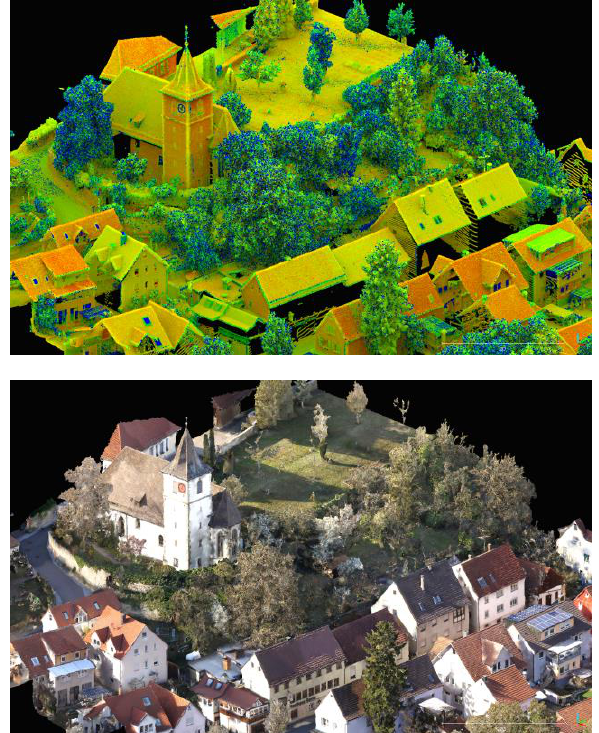
Figure 9. LiDAR point cloud with corresponding colour coded reflectance (top) and 3D mesh with corresponding image texture (bottom)